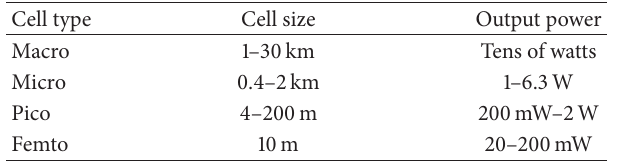
Table 3: Cell size and transmitted power for a heterogeneous network [20].